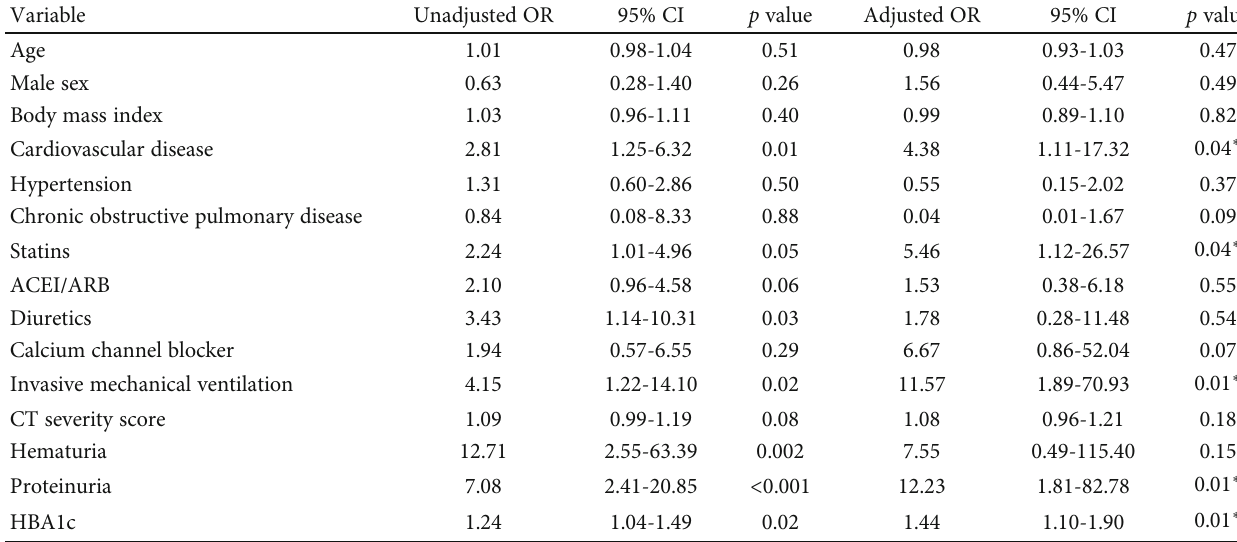
Table 4: Univariate and multivariate analyses of covariates associated with AKI in COVID-19 patients with diabetes.